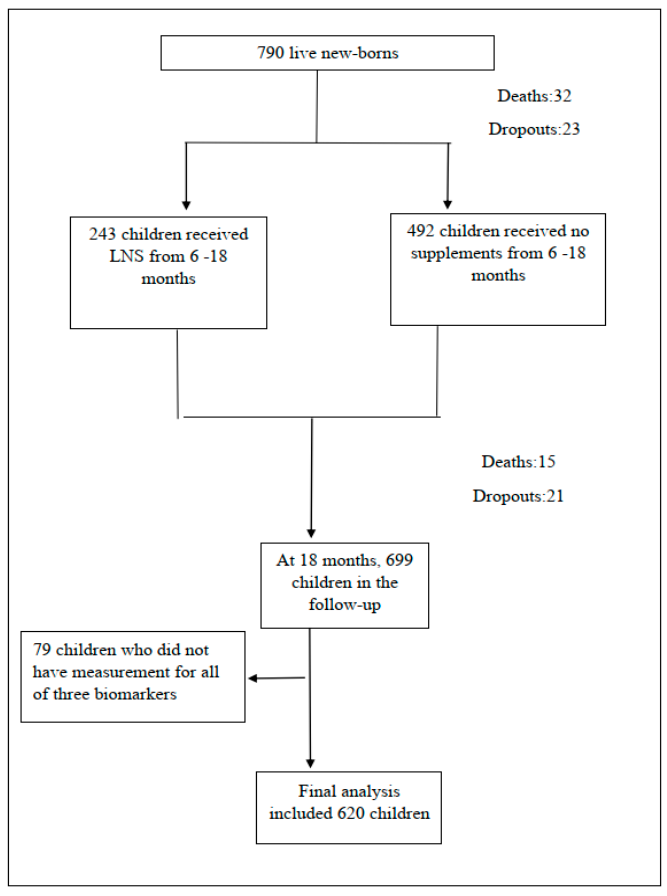
Figure 1. Flow chart of participants.